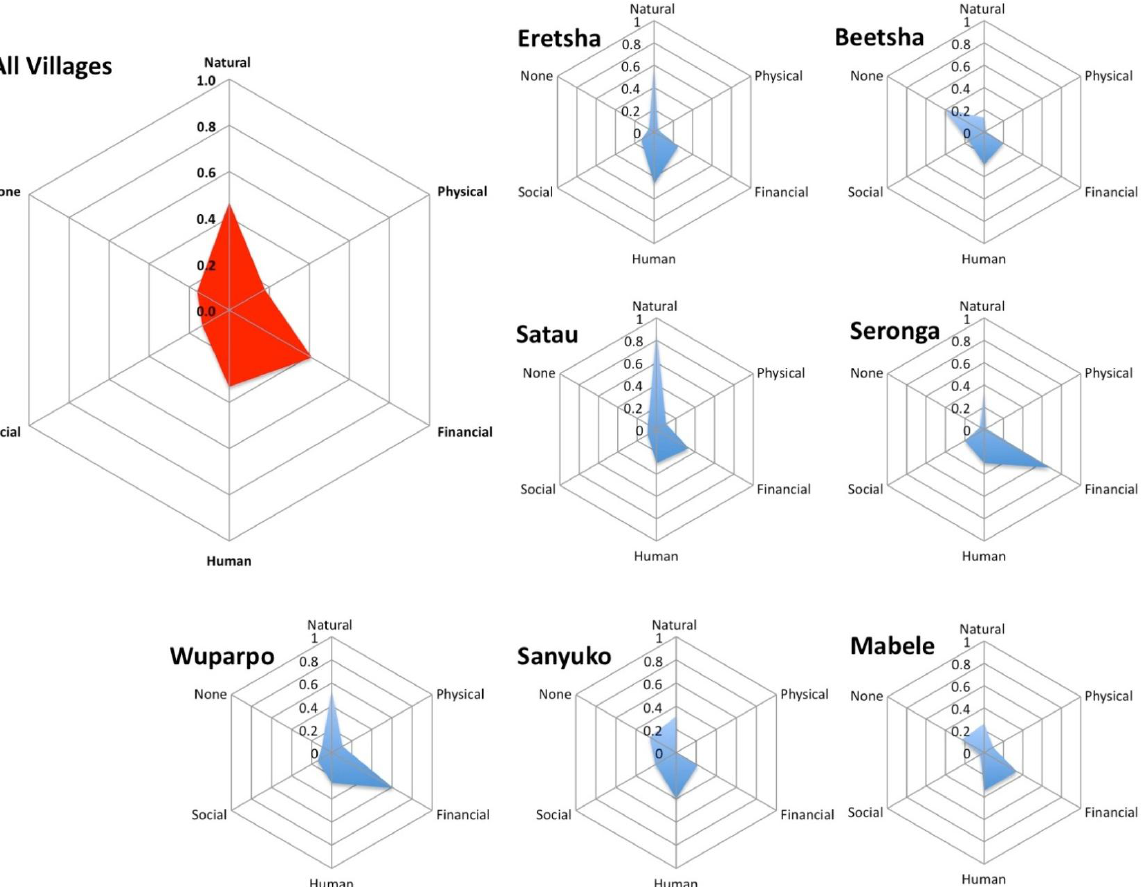
Figure 3. Web diagrams illustrating each village’s R values by livelihood asset including: natural, physical, financial, human, and social. The none portion of the web diagram illustrates those surveyed that did not perceive any risks to their livelihoods or did not respond to the